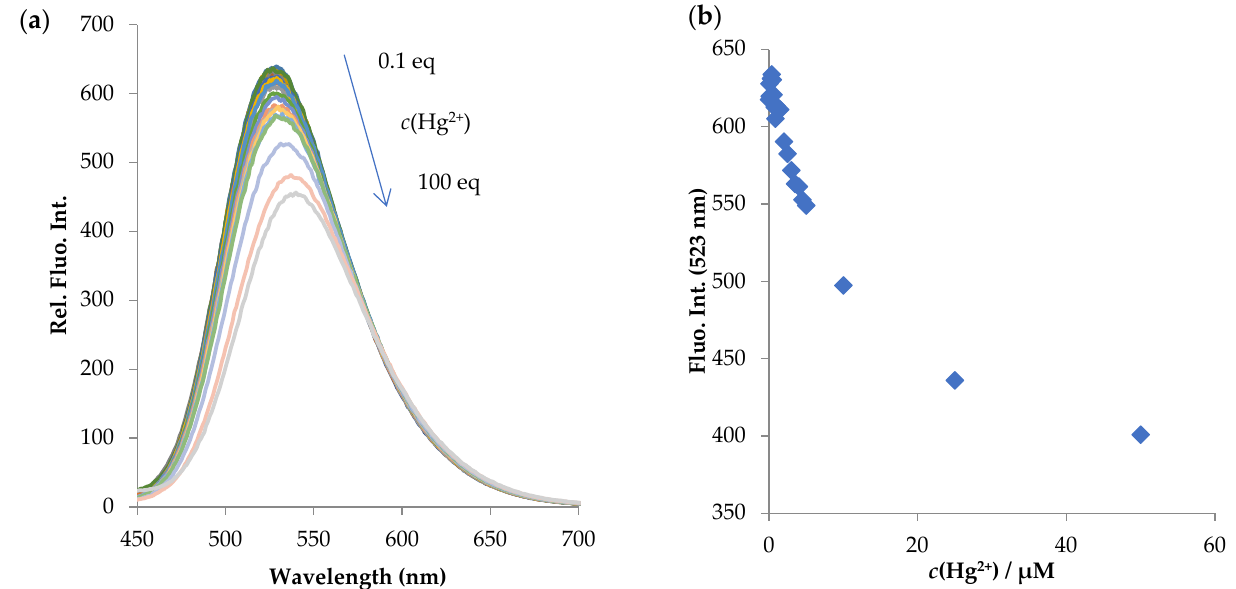
Figure 7. ( a ) Fluorescence titration spectra of NI-1 ( c = 5.00 × 10 − 7 M) with Hg 2+ in concentration range 5.00 × 10 − 8 M–5.00 × 10 − 5 M (shown in the graph ranging from 0.1 eq to 100 eq) in MeOH/buffer (v/v, 1/2, pH = 5.5), λ exc = 410 nm. ( b ) Plot of fluorescence quenching at 523 nm of NI-1 as a function of Hg 2+ ion concentration.